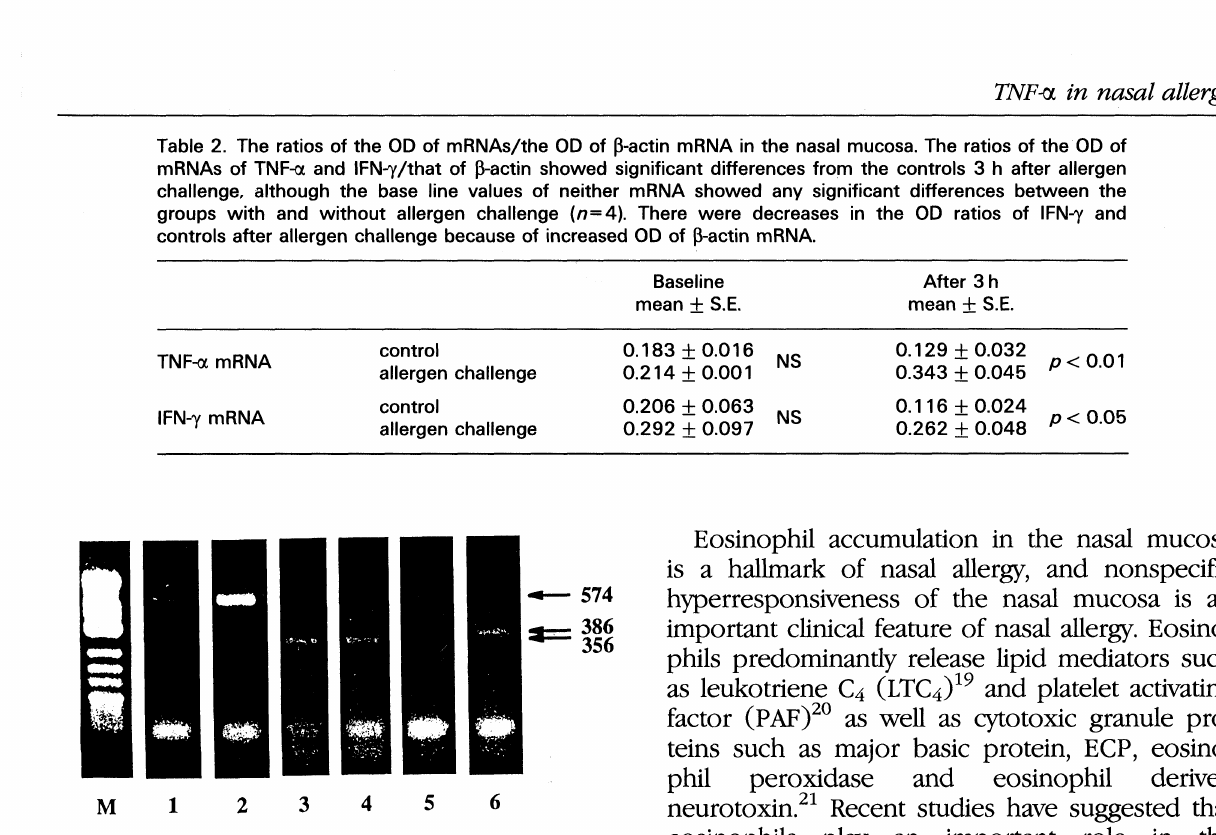
FIG. 3. Effect of allergen challenge on TNF- mRNA and IFN-7 mRNA in the nasal mucosa. The TNF- mRNA and IFN- mRNA were increased in the nasal mucosa by specific allergen chal- lenge in vitro. The figure shows expression of TNF- mRNA and IFN-y mRNA in allergic nasal mucosa after 3 h incubation follow- ing challenge with Derrnatophagoides farine extract. Lane M, DNA molecular weight marker; Lane 1, actin (without allergen challenge); Lane 2, actin (with allergen challenge); Lane 3, TNF- (control); Lane 4, TNF- (with allergen challenge); Lane 5, IFN- (control); Lane 6, IFN-y (with allergen challenge). Ratios of the OD of TNF- mRNA/the OD of actin mRNA and the OD of IFN-y mRNA/the OD of -actin mRNA were